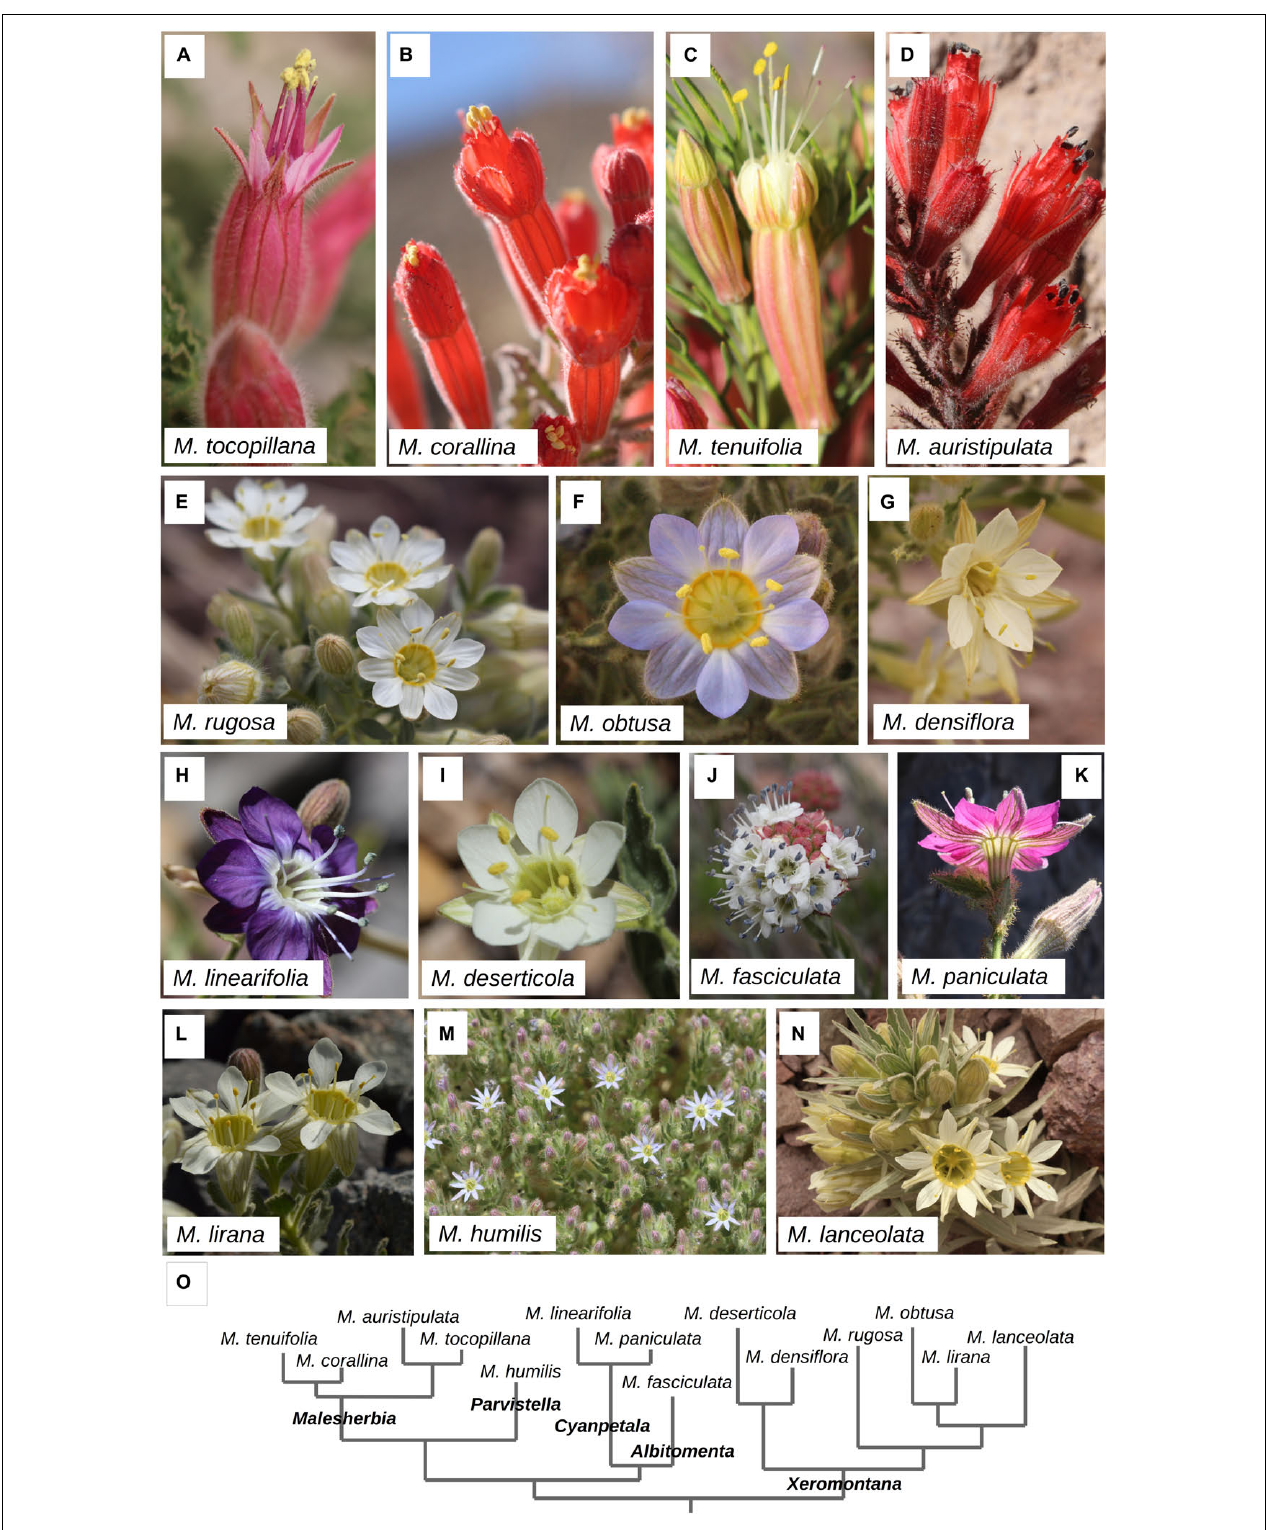
FIGURE 1 | Chilean Malesherbia species studied in this work. (A–D) Species whose flowers show a prominent reddish tubular shape, all of them belonging to the section Malesherbia . (E–N) Species with flowers of radiate shape including minute flowers and globular inflorescence and corresponding to the remaining four